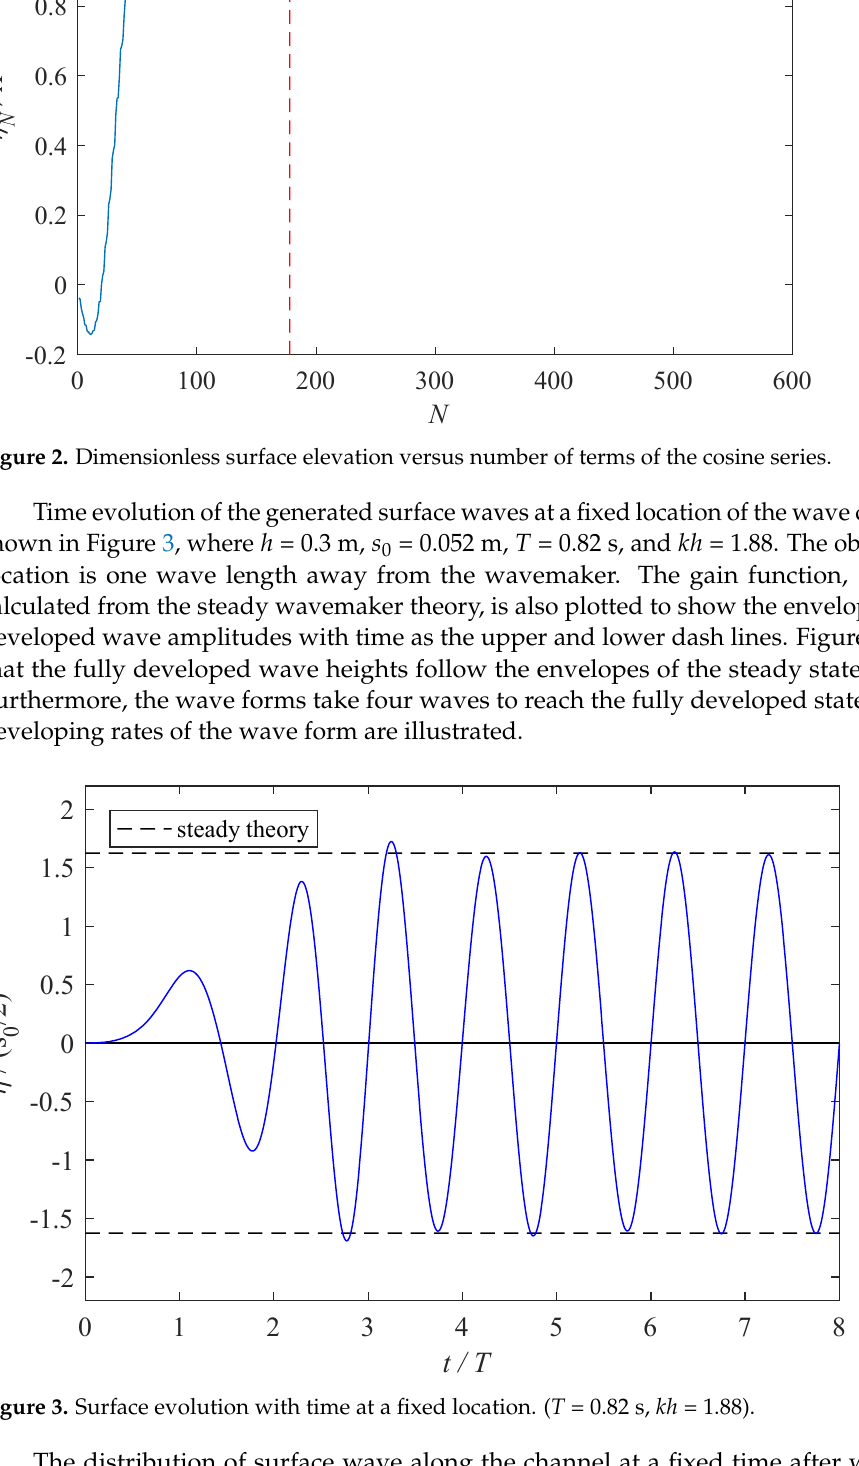
Figure 4. Wave elevations along the channel at 15 t T = . In the wavemaker theory, motions of the wavemaker generate propagating waves and accompanied evanescent waves that decay while moving away from the wavemaker. In front of the wavemaker, the fully developed wave form calculated by the present analytical solution, the steady theory, and the propagating waves are plotted in Figure 5. Figure 5 shows that after the waves are fully developed, the present time domain solution (line) precisely matches the wave length and amplitude as the steady theory (circle). On the other hand, the difference between steady wave form and the propagating wave form (red dash line) indicates the evanescent wave in front of the wavemaker.